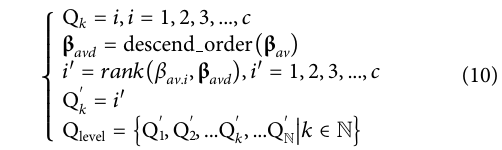
Algorithm 1: User classi fi cation method based on the spectral clustering